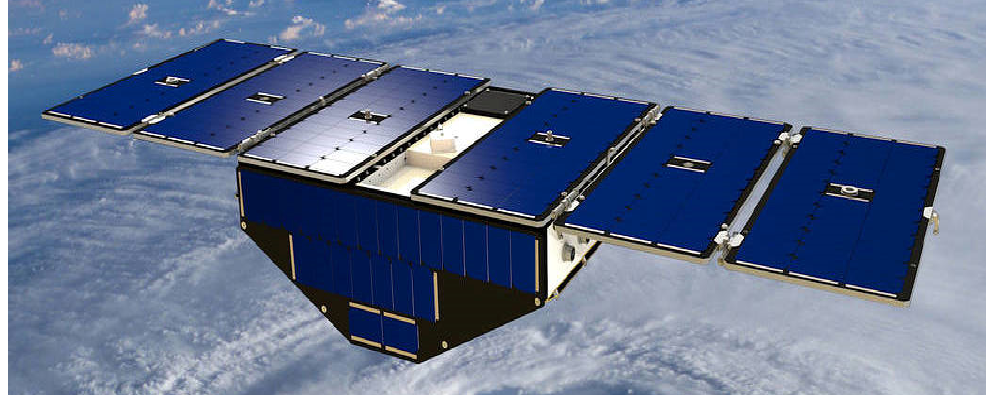
Figure 1. NASA’s Cyclone Global Navigation Satellite System (CYGNSS) mission, a constellation of eight microsatellites, will improve hurricane forecasting by making measurements of ocean surface winds in and near the eye wall of tropical cyclones, typhoons and hurricanes throughout their life cycle. Figure taken from [0] in compliance with NASA’s image use policy [ Error! Reference source not found. ].